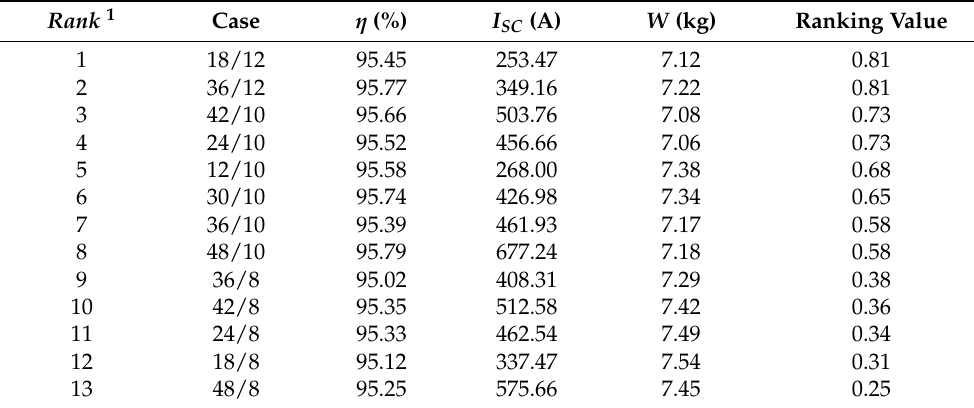
Table 3. The comprehensive rank of feasible combination.